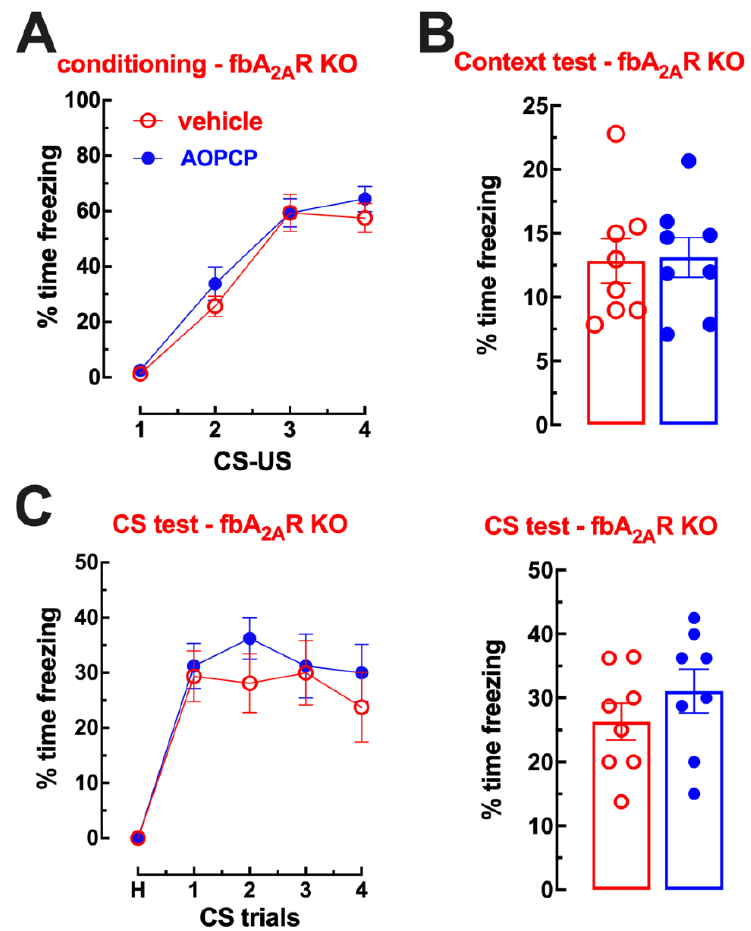
Figure 5. The effect of AOPCP on fear memory is absent in forebrain A 2A R knockout mice. ( A ) Fear conditioning of AOPCP-treated and saline-treated forebrain (fb)A 2A R knockout (KO) mice. The learning curve of cued fear conditioning was similar between AOPCP- and saline-treated mice lacking A 2A R in forebrain neurons; moreover, both groups significantly increased their freezing behavior at each CS–US trial, showing a normal acquisition of fear. ( B ) Contextual fear memory: AOPCP-treated fbA 2A R KO mice displayed equal freezing behavior comparing to the saline-treated group upon re-exposure to the conditioning chamber (context A) in the absence of the US, 1 day after fear conditioning. ( C ) Cued fear memory: AOPCP-treated fbA 2A R KO mice displayed a cued fear memory, assessed as a percentage of freezing, similar to the saline-treated WT littermates upon presentation of the CS in the 4 trials after a 2 min habituation (H) period in the absence of the US, in a novel context B, 2 days after fear conditioning. The values are mean ± SEM of n = 8 experiments. 2.2. Inhibition of CD73 Blunts A 2A R-Mediated Control of Amygdala